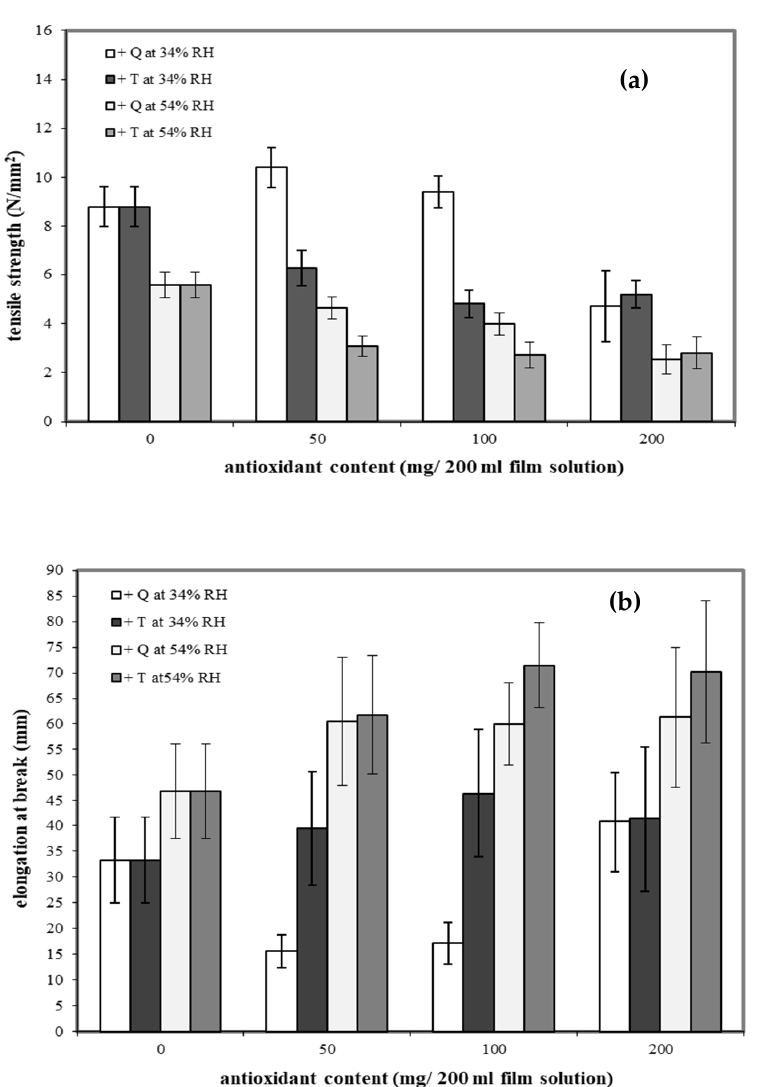
Figure 1. Effect of antioxidant (quercetin (Q) and tertiary butylhydroquinone (TBHQ, or T)) addition and relative humidity on tensile strength ( a ) and elongation at break ( b ) of cassava starch/gelatin composite